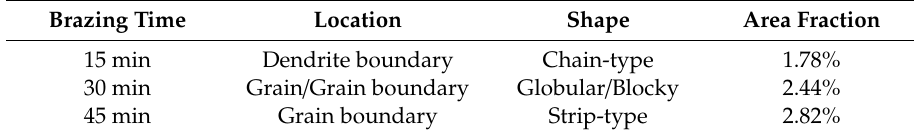
Figure 4. ( a ) XRD patterns of the mixed filler powder and WGB region bonded at di ff erent brazing times, ( b ) high magnification XRD patterns of 40–50 degreee in ( a ). Table 2 . Summary of location, shape, and area fraction of M 3 B 2 borides in the WGB region. Brazing Time Location Shape Area Fraction 15 min Dendrite boundary Chain-type 1.78% 30 min Grain/Grain boundary Globular/Blocky 2.44% 45 min Grain boundary Strip-type 2.82% (Note, M 3 B 2 particles in the electron micrographs were counted and measured by Photoshop 7.0 and Image Pro 4.5.).